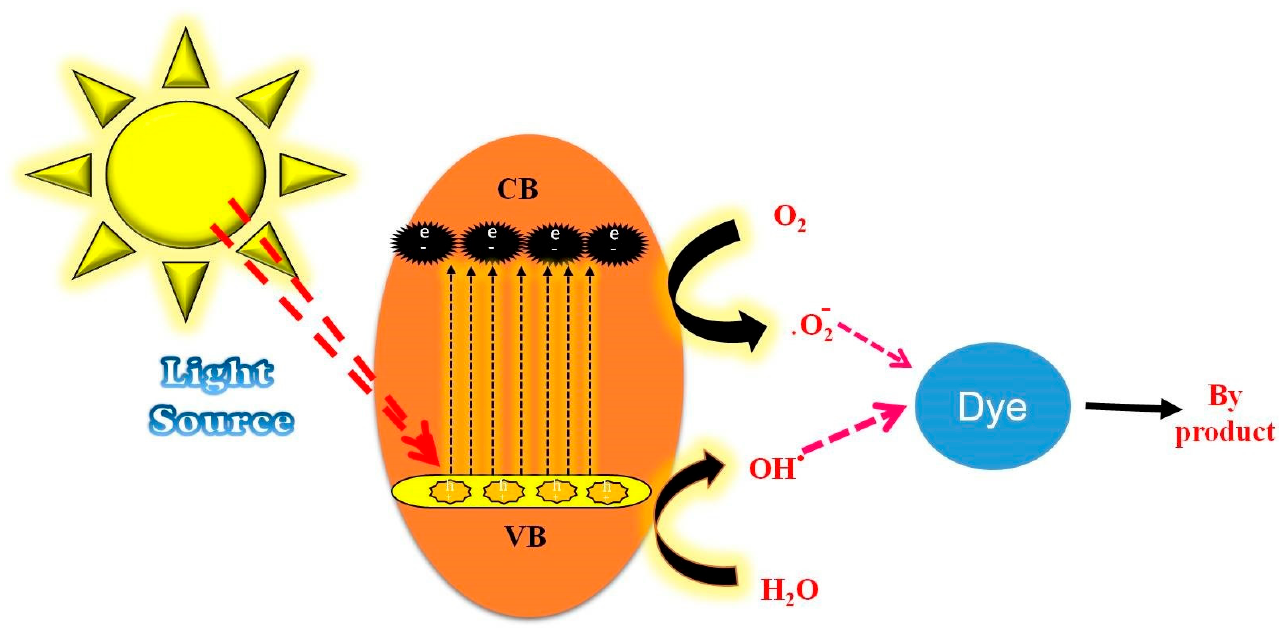
Figure 8. Mechanism of photocatalytic dye degradation of NiSe NPs. Table 1. Photocatalytic dye degradation comparison table of various Metal-Se-NPs.